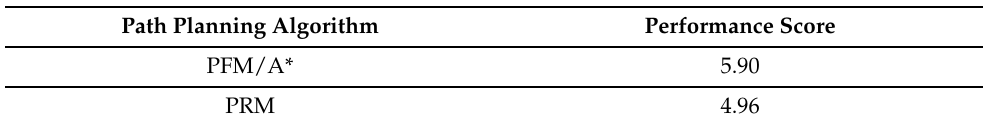
Table 10. Performance Score Output for Case Study II.